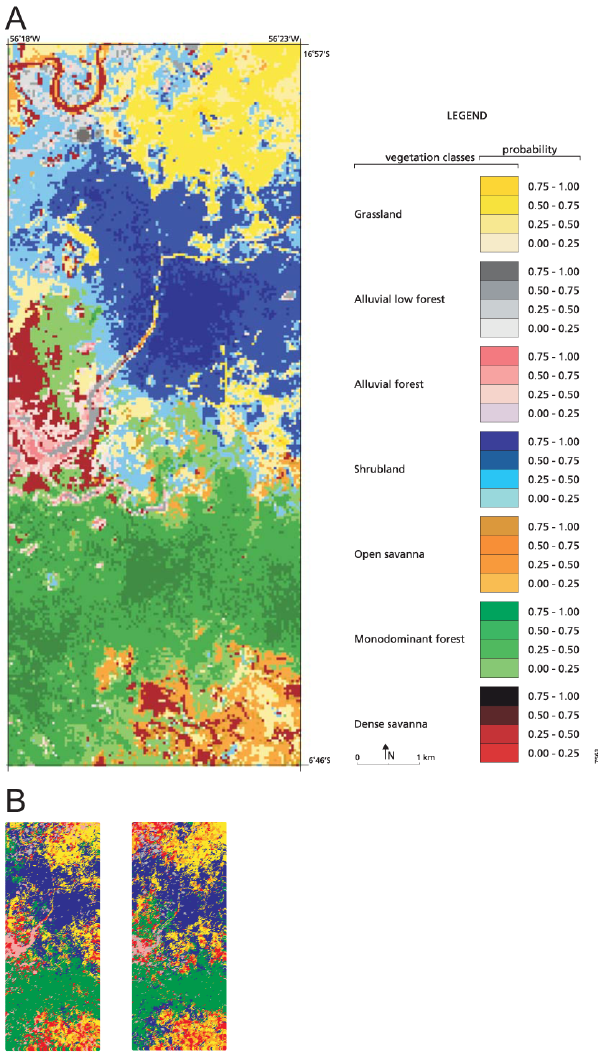
Fig. 8. Results of Monte Carlo simulation, using 1000 random sim- ulations. (A) The colors on the map indicate the vegetation class with the highest probability of occurrence at a cell. A color gradi- ent is used to show the value of this highest probability; (B) maps of two single random realizations, color scale is identical to Fig. 8.